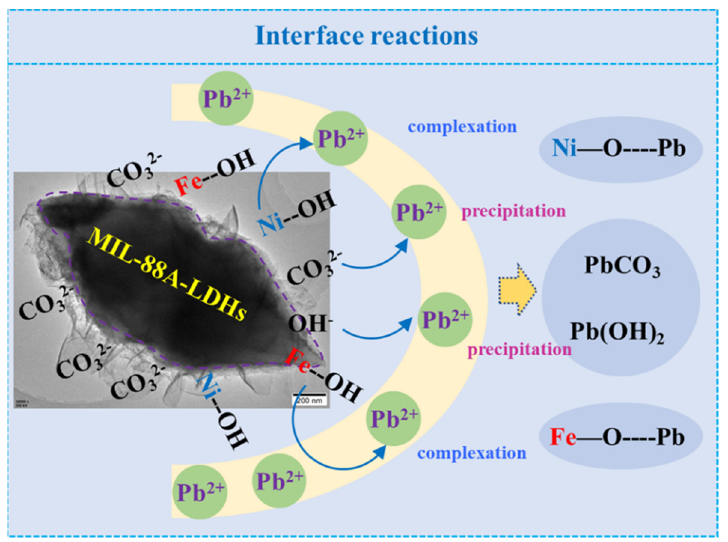
Figure 9. Schematic illustration of the mechanism of Pb 2+ adsorption by